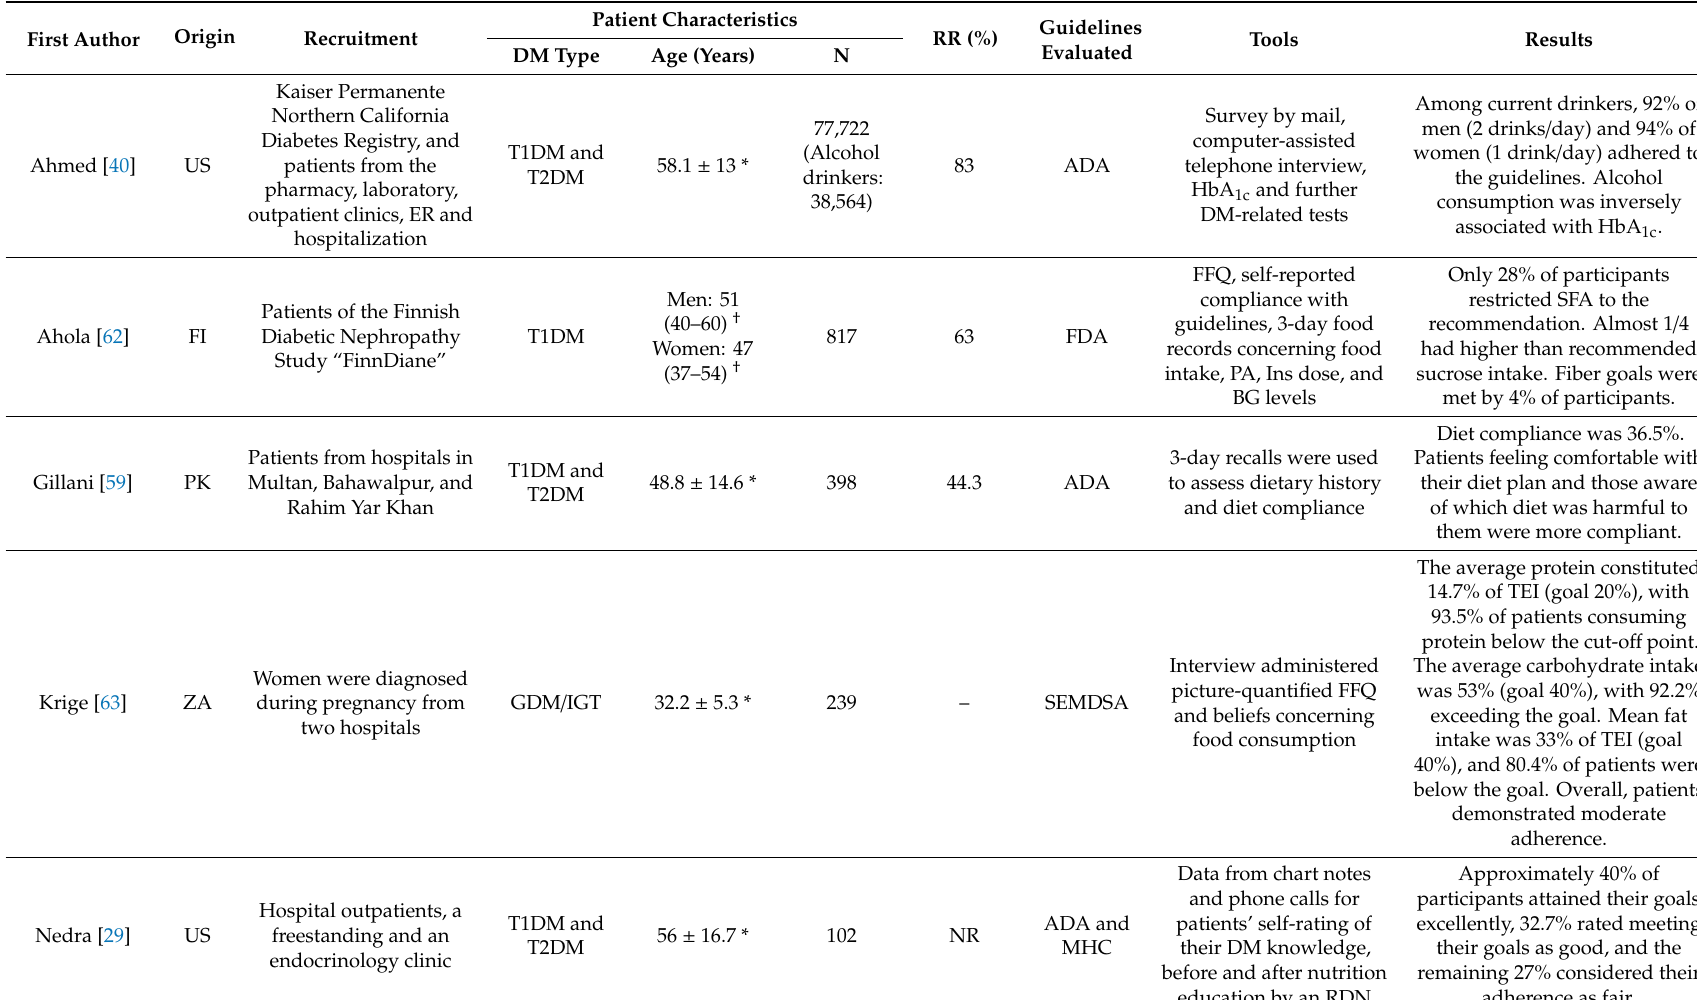
Table 4. Cross-sectional studies assessing adherence to the dietary guidelines among patients with